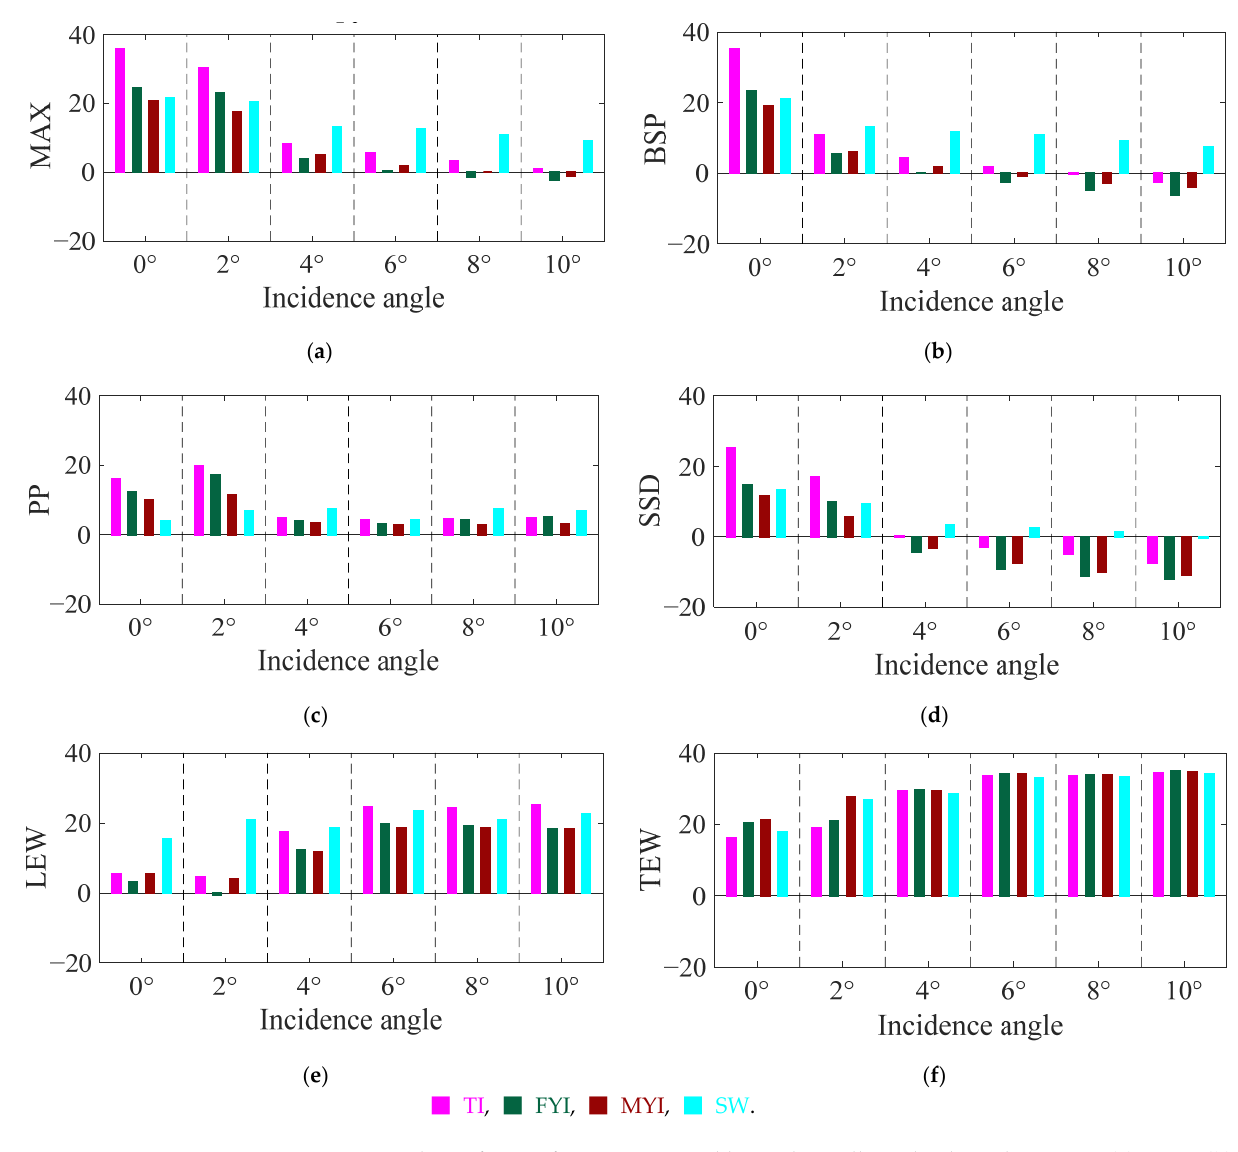
Figure 6. Values of every feature processed logarithmically and enlarged 10 times. ( a ) MAX; ( b ) BSP; ( c ) PP; ( d ) SSD; ( e ) LEW; ( f ) TEW.